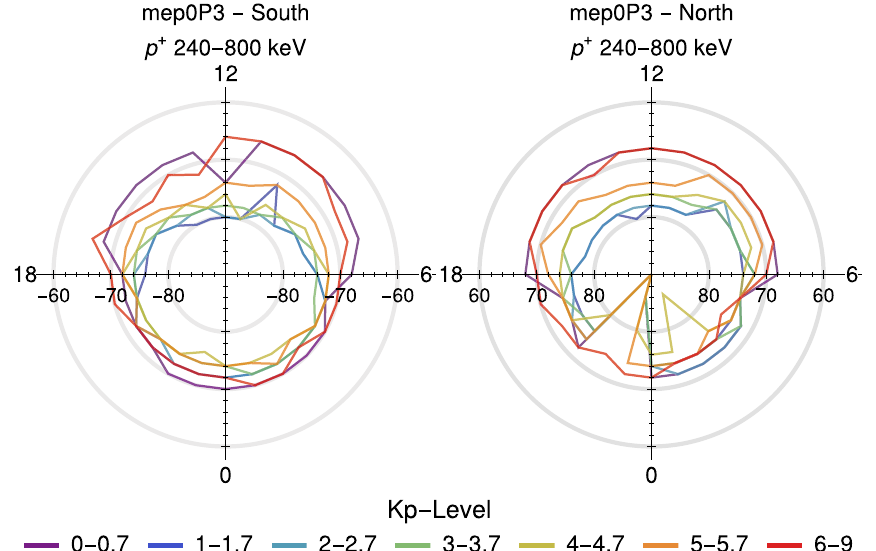
Figure 6. The boundary of empirically determined PPFD area for the proton channel mep0P3 is shown for southern (left) and northern (right) hemispheres at different Kp levels in MLAT vs. MLT coordinates. The polar plots are centred on one of the magnetic